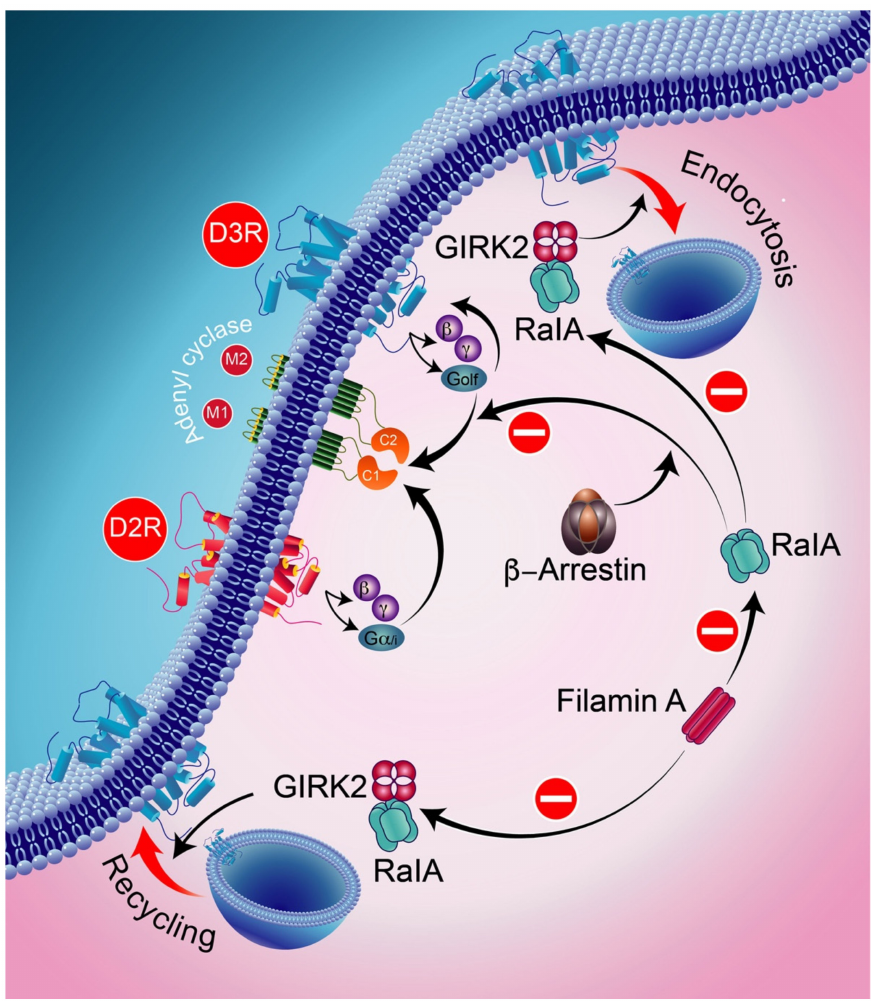
Figure 7. Ral, a part of the small GTPase of the Ras family, is involved in receptor endocytosis. GRK2 and β -arrestins are implicated in the blocking activities of RalA acting on D3R-mediated signaling and D2R intracellular trafficking. RalA is involved in GRK2-mediated receptor phosphorylation in the constitutive recycling and resensitization of D2Rs. The D3R, through its constitutive action with β -arrestin, binds constitutively to active RalA, thereby resulting in the constitutive inhibition of D3R signaling. GIRK2-protein-regulated inward-rectifier potassium channel